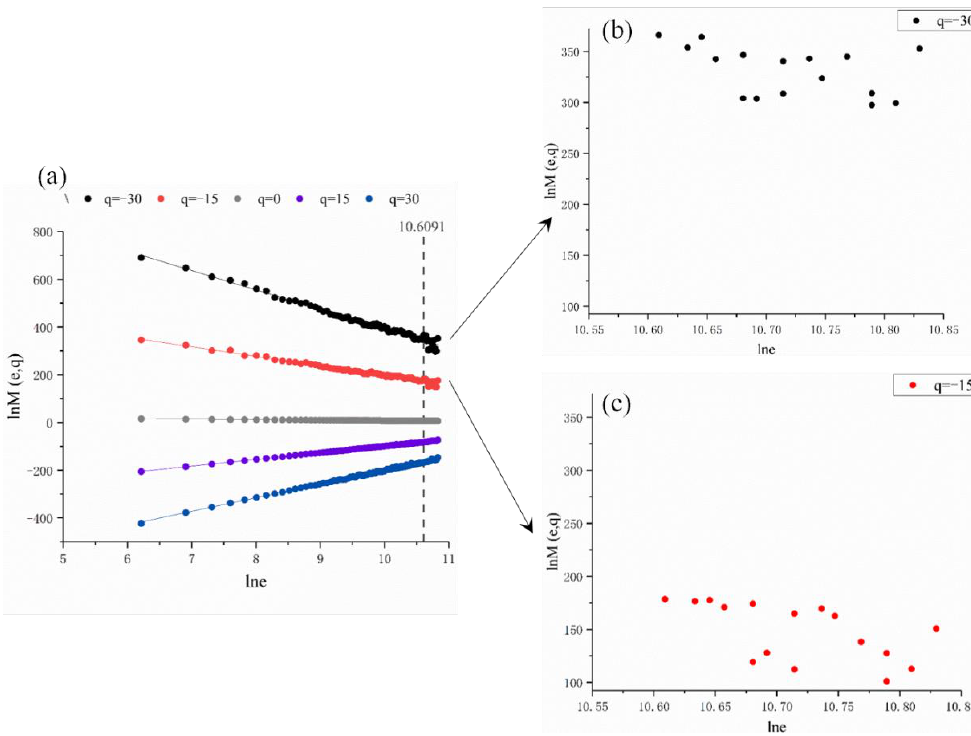
Figure 8. The relationship between ln 𝑀(𝑒,𝑞) and ln 𝑒 in the Yellow River Basin. The relationship between ln 𝑀(𝑒,𝑞) and ln𝑒 ( a ) When e is [500, 50,000]; ( b ) When e is [40,000, 50,000] and q is − 30; ( c ) When e is [40,000, 50,000] and q is − 15.